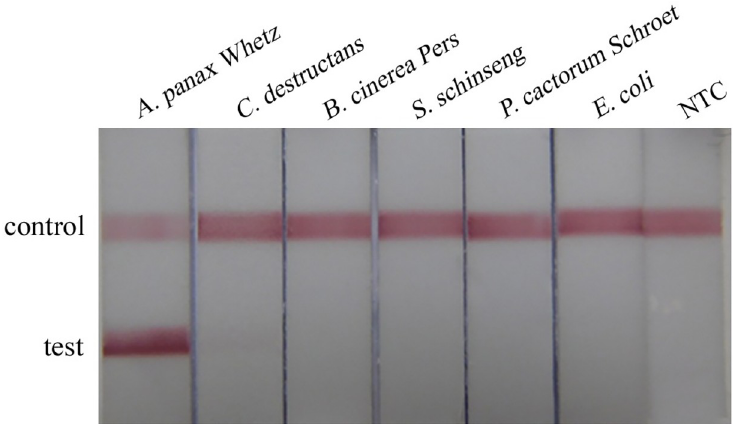
Fig 5. The specificity of STNPCR-LFBA. A . Whetz Alternaria panax-Alternaria panax Whetz, C . destructans- Cylindrocarpon destructans , B . cinerea Pers- Botrytis cinerea Pers, S . schinseng-Sclerotionia schinseng , P . cactorum Schroet-Phytophora cactorum Schroet , E . coli-Escherichia coli , NTC: no template control.